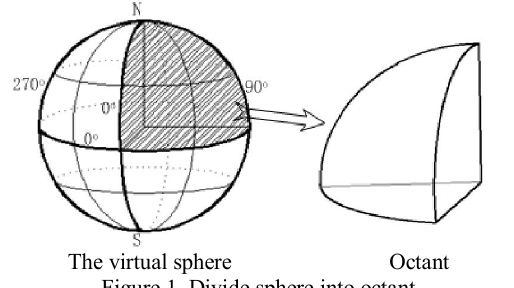
Figure 1. Divide sphere into octant